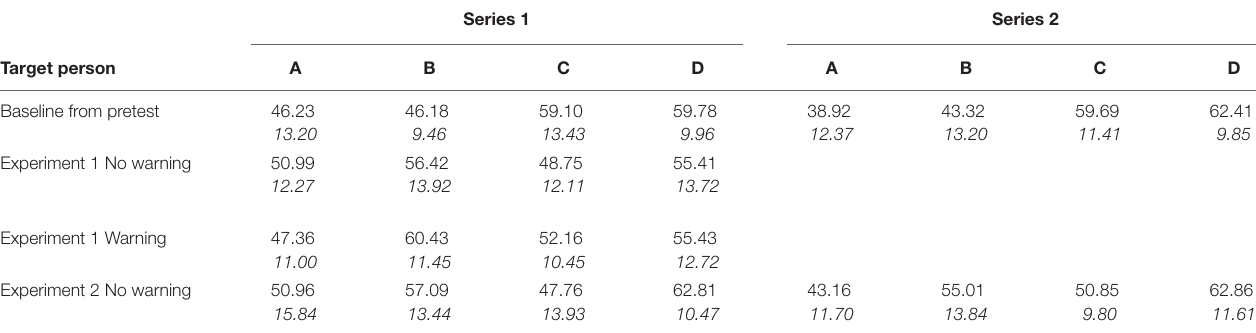
TABLE 3 | Means and standard deviations (italics) of target evaluations obtained in Experiments 1 and 2, as a function of instruction conditions (extra warning vs. no warning to ignore repetitions) and two stimulus series. Series